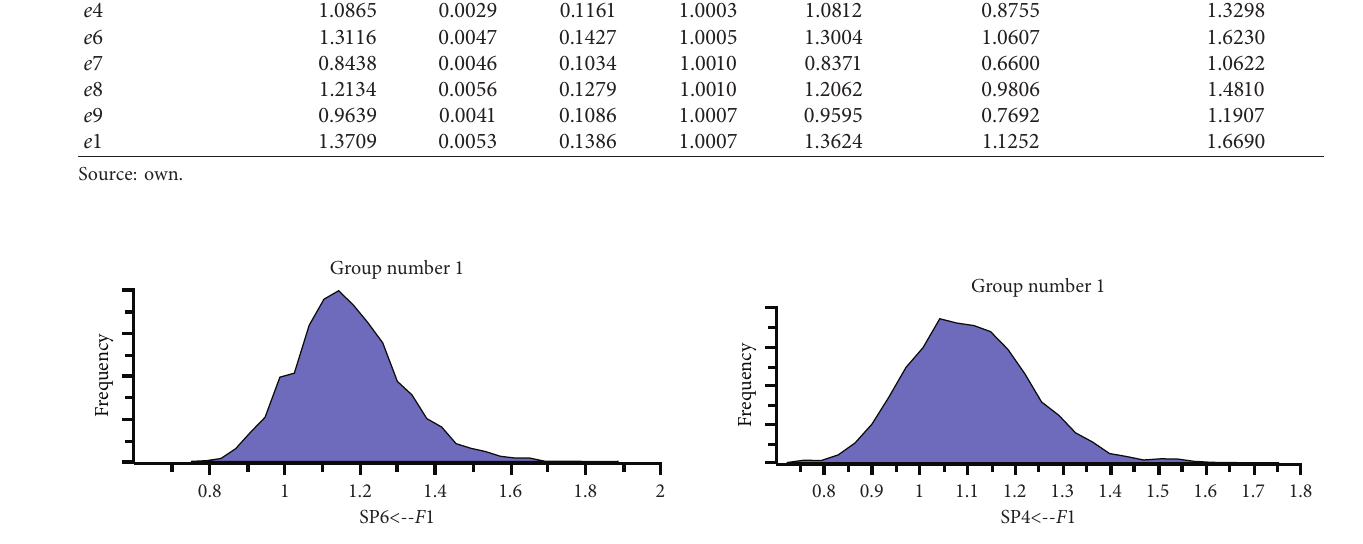
Figure 2: Bayesian diagnostic SP6. Figure 3: Bayesian diagnostic